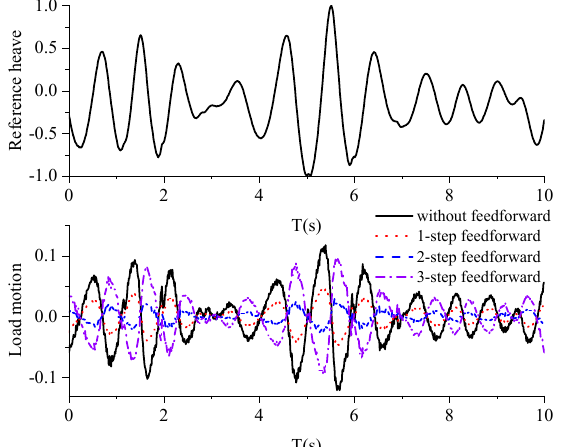
Figure 14. Heave motions of the payload of irregular structure motion based on actual-data feedfor- ward control.